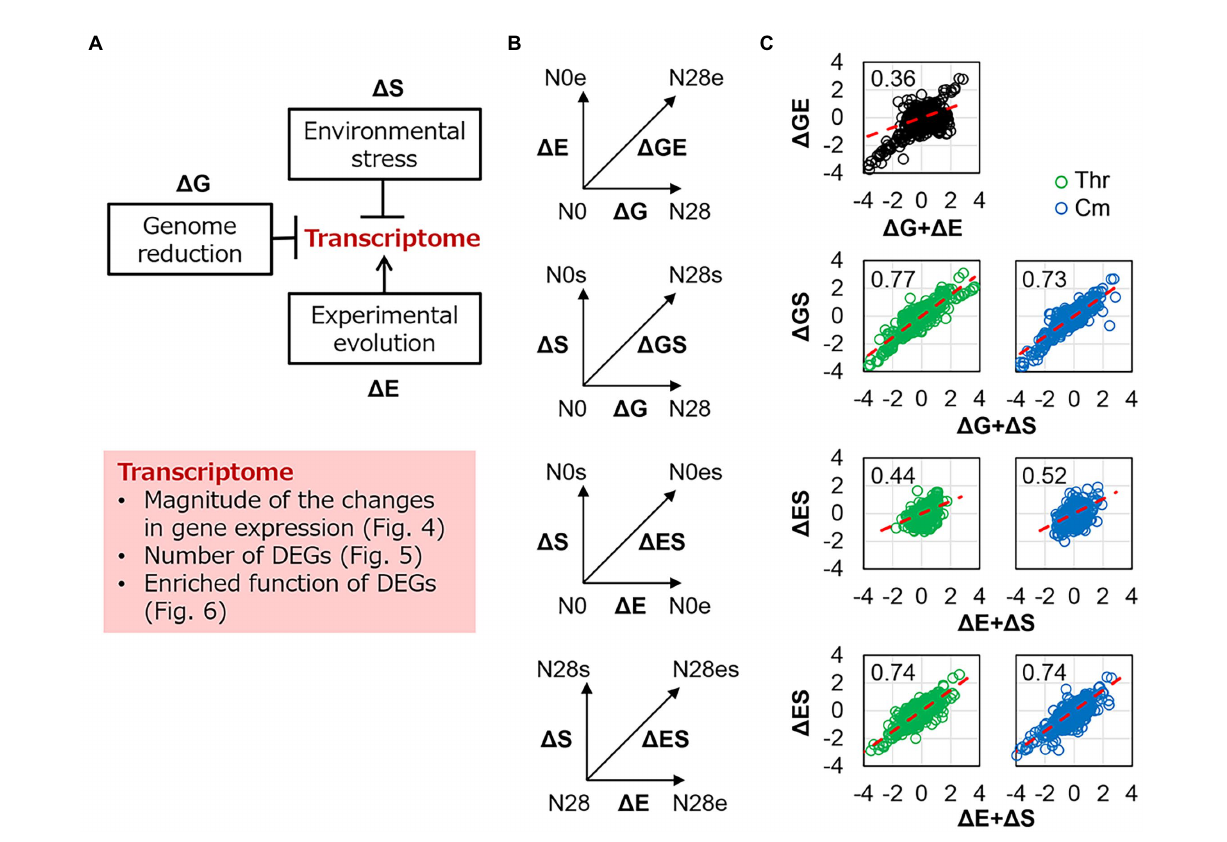
FIGURE 4 Epistasis in transcriptome reorganization. (A) Schematic drawing of the contributions of genomic, environmental, and evolutionary changes to transcriptomes. The box shadowed in pink highlighted the analytical points. (B) Schemes of evaluating the epistasis in transcriptome reorganization. Δ G, Δ E, and Δ S represent the transcriptional changes caused by the single interruption of genome reduction, environmental stress, and experimental evolution, respectively. Δ GE, Δ GS, and Δ ES represent the simultaneous transcriptional changes caused by the dual interruption of any pairs. (C) Epistasis in transcriptome reorganization. The horizontal and vertical axes show the additive changes (the sum of the changes caused by any single interruption) and the simultaneous changes (the changes caused by dual interruptions) in gene expression, respectively. The linear regression slopes are indicated, which were theoretically interpreted in the Materials and Methods. The red dashed lines represent the slope of 1. Green and blue indicate the addition of Thr and Cm in the culture,